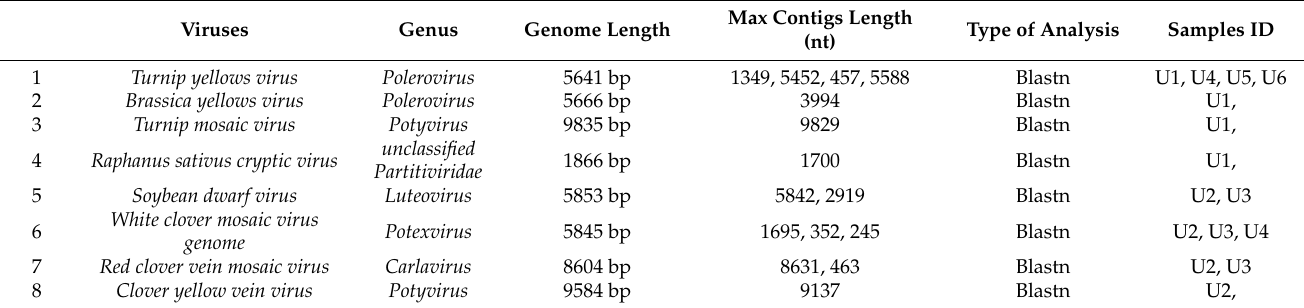
Table 5. Details of viruses detected through